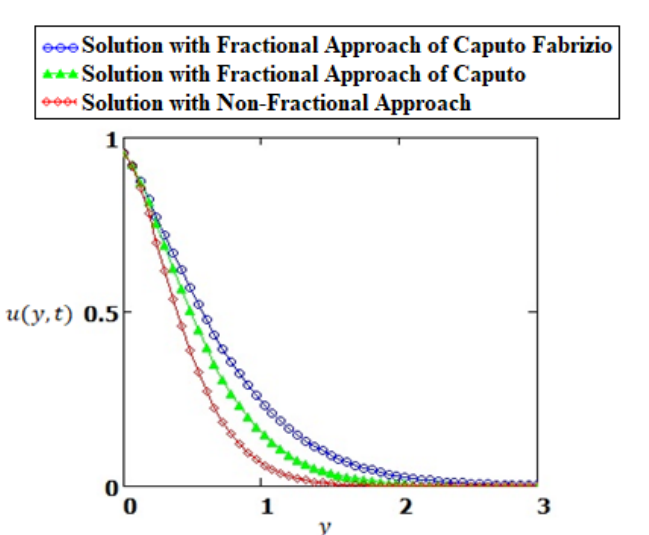
Figure 5. Comparative illustration between fractional approaches (Caputo-Fabrizio and Caputo) and non-fractional approach with R 0 = 1, K 0 = 0.53, ZT 0 = 7, ω = 0.5, M = 0.1, t = 1, Pr = 8 .